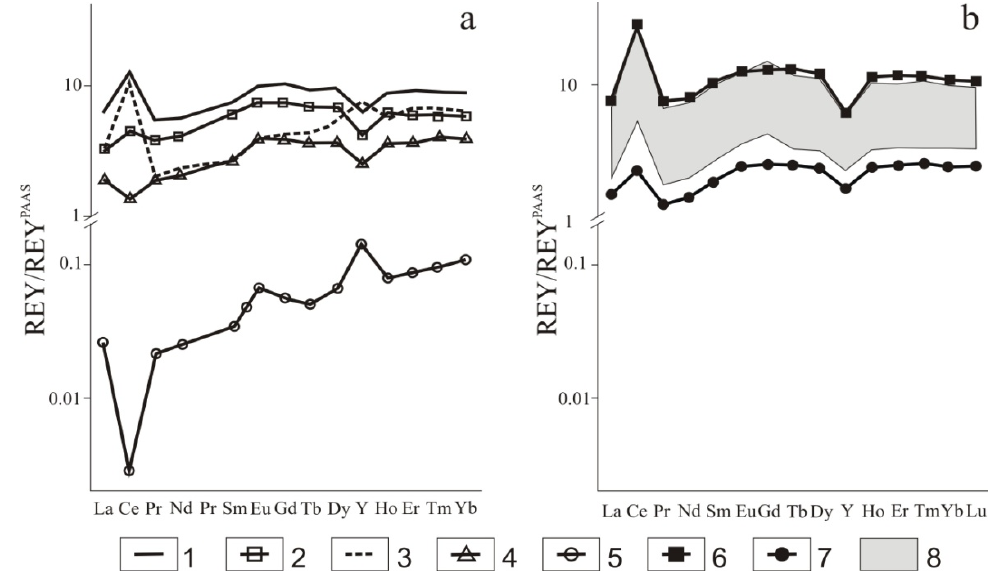
Figure 7. Shale-normalized (PAAS after [47]) REY patterns of Fe-Mn deposits of differing genesis ( a ) and Fe-Mn sandy-gravel deposits from the Holes 431 and 431A cores from the Yōmei Guyot ( b ).